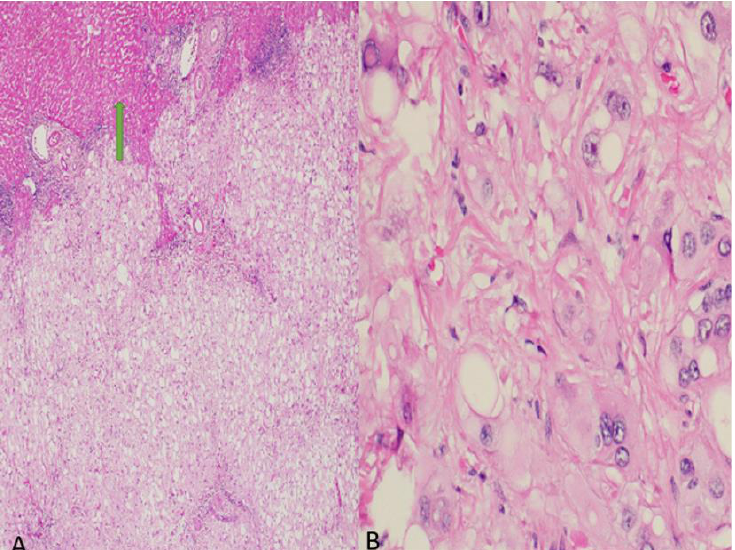
Figure 2. ( A ) H&E (10×): Ill-defined lesion with microcystic areas with normal liver parenchyma at the periphery (arrow). ( B ) H&E (40×): Epithelioid pleomorphic cells with prominent nucleoli with clear to eosinophilic bubbly cytoplasm.